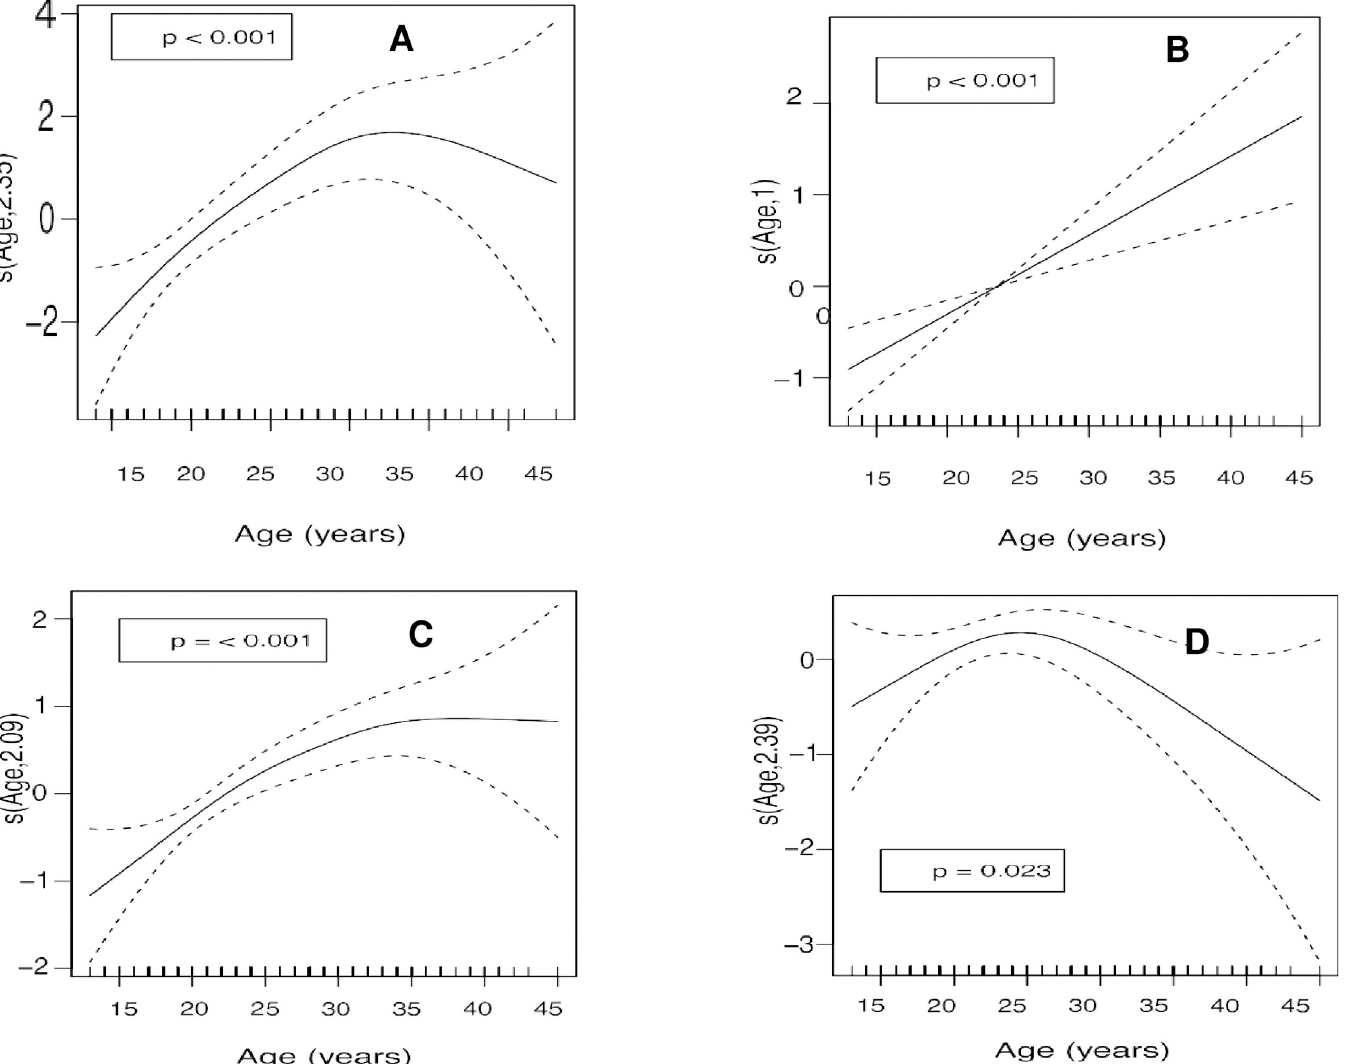
Fig 3. Analysis of the age of the mother versus A) Body mass index, B) Arterial hypertension, C) HIV infection, D) Previous abortions. Adjusted by the number of